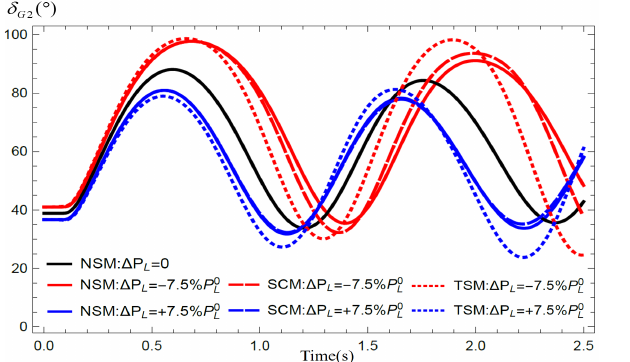
Figure 4. Approximated trajectories of δ G2 with (cid:52) P L = ± 7.5% P L0 by the SCM and the TSM in fault